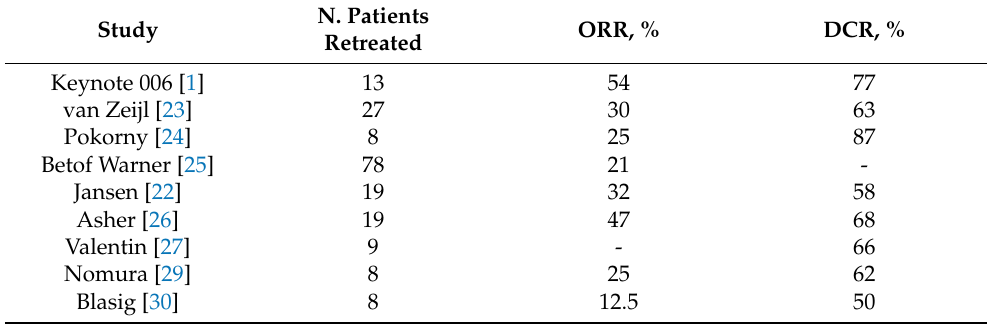
Table 2. Response to the second course of immunotherapy in patients who had disease progression.